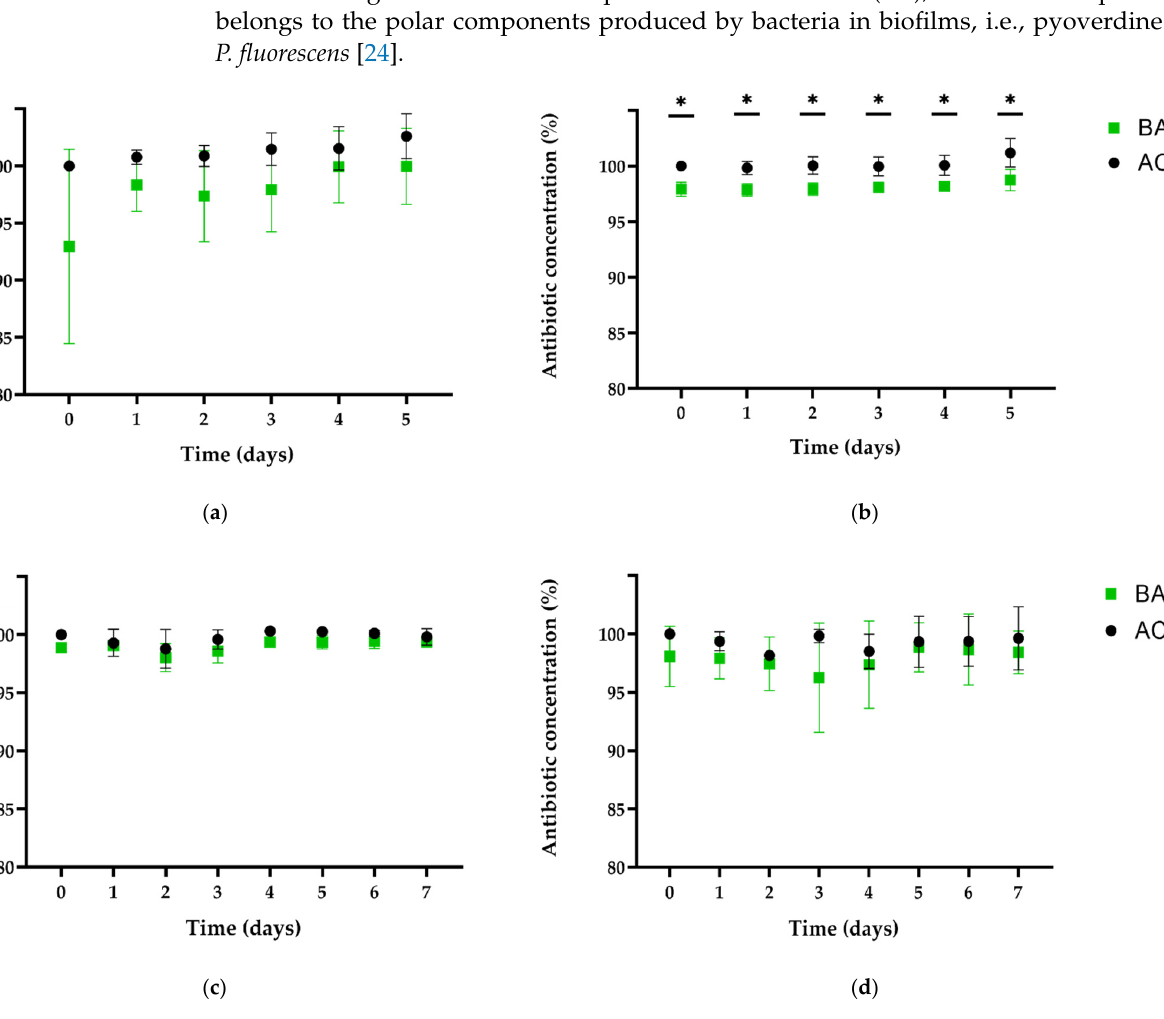
Figure 2. Antibiotic concentration (%) in the supernatant of pipes without biofilm (AC) or with 7-day-old biofilms (BA). Results are shown for daily samplings starting 1 h after application (0) over 5 or 7 days. ( a , b ) Data for biofilms with P. aeruginosa; ( c , d ) Data for biofilms with P. fluorescens. ( a , c ) Results for SDZ (initial application: 150 mg L − 1 ); ( b , d ) Results for TMP (initial application: 30 mg L − 1 ). * Concentrations significantly different between the antibiotics exposed to biofilms and control pipes ( p ≤ 0.005).